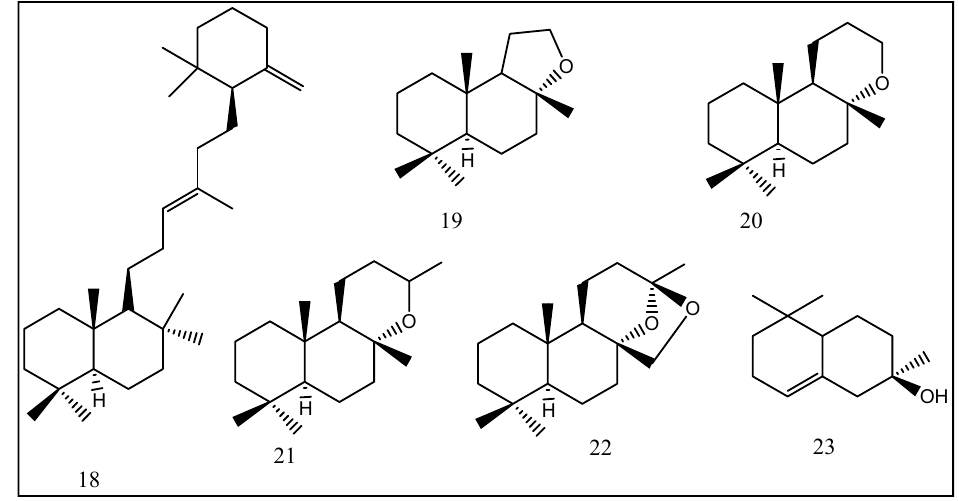
Figure 8. Amber and the most characteristic ambergris smelling compounds.